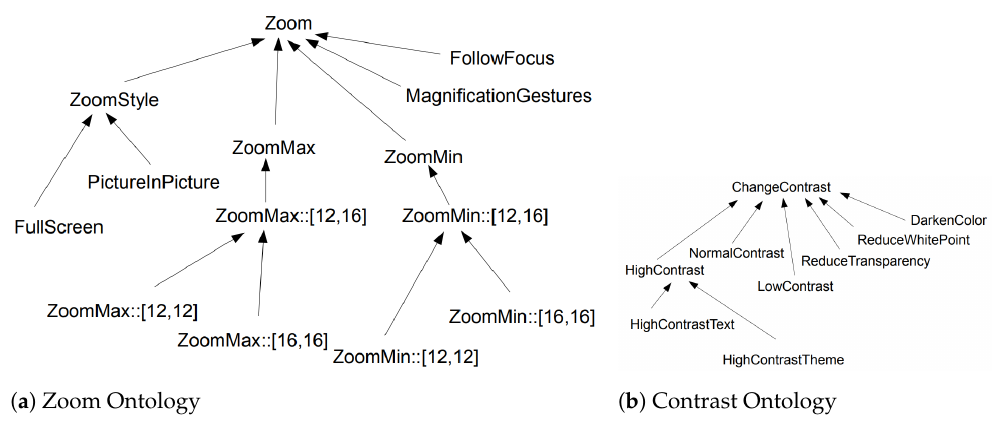
Figure 6. Ontology from domain knowledge on zoom and contrast.